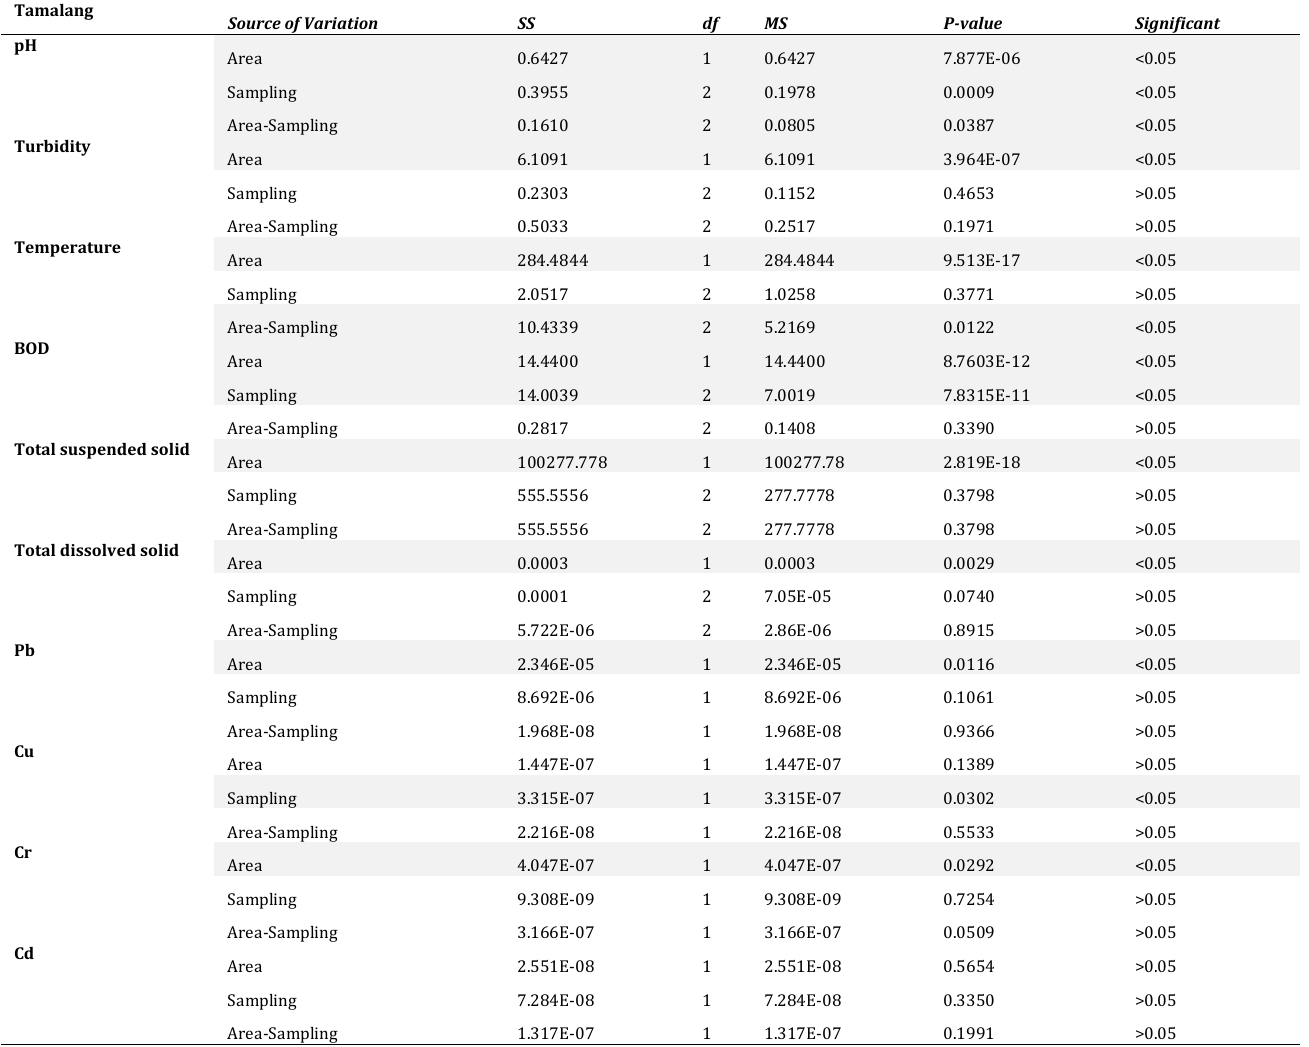
Table 4: The ANOVA Two Way for spring-water at Tamalang village, Kota Belud.